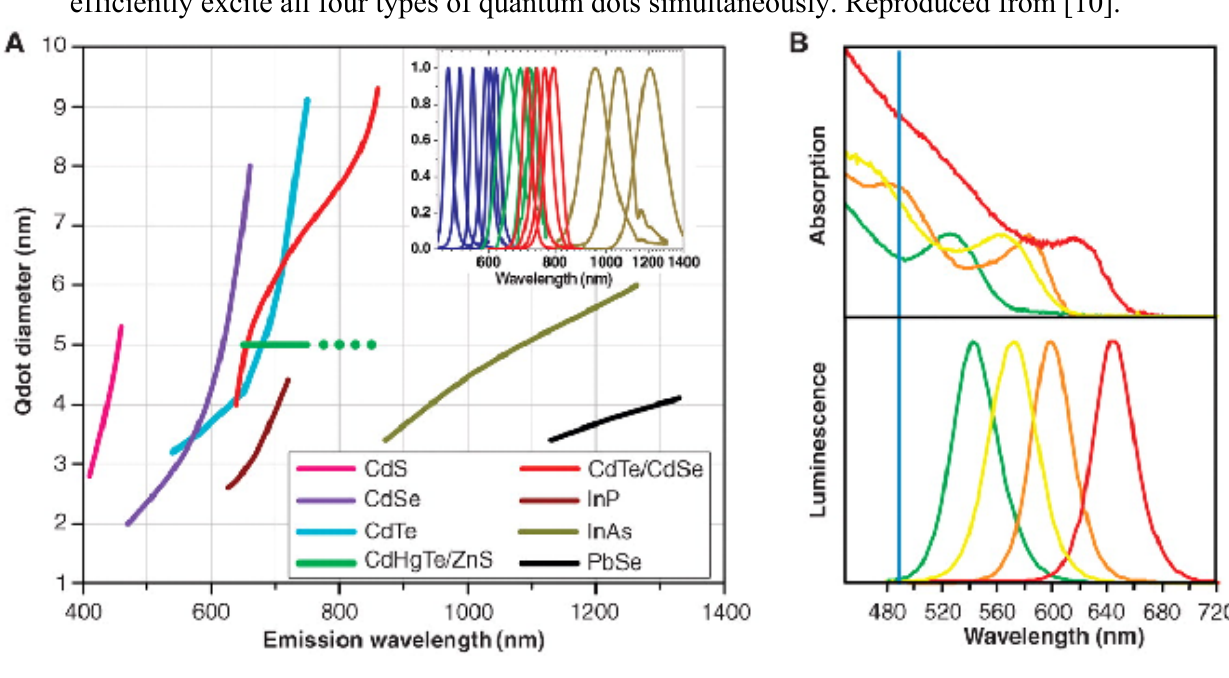
Figure 1. (A) Emission maxima and sizes of quantum dots of different composition. Quantum dots can be synthesized from various types of semiconductor materials (II-VI: CdS, CdSe, CdTe, etc.; III-V: InP, InAs, etc.; IV-VI: PbSe, etc.). The curves represent experimental data from the literature on the dependence of peak emission wavelength on quantum diameter. The range of emission wavelength is 400 to 1350 nm, with size varying from 2 to 9.5 nm. All spectra are typically around 30 to 50 nm (full width at half maximum). Inset: Representative emission spectra for some materials. (B) Absorption (upper curves) and emission (lower curves) spectra of four CdSe/ZnS quantum dot samples. The blue vertical line indicates the 488-nm line of an argon-ion laser, which can be used to efficiently excite all four types of quantum dots simultaneously. Reproduced from